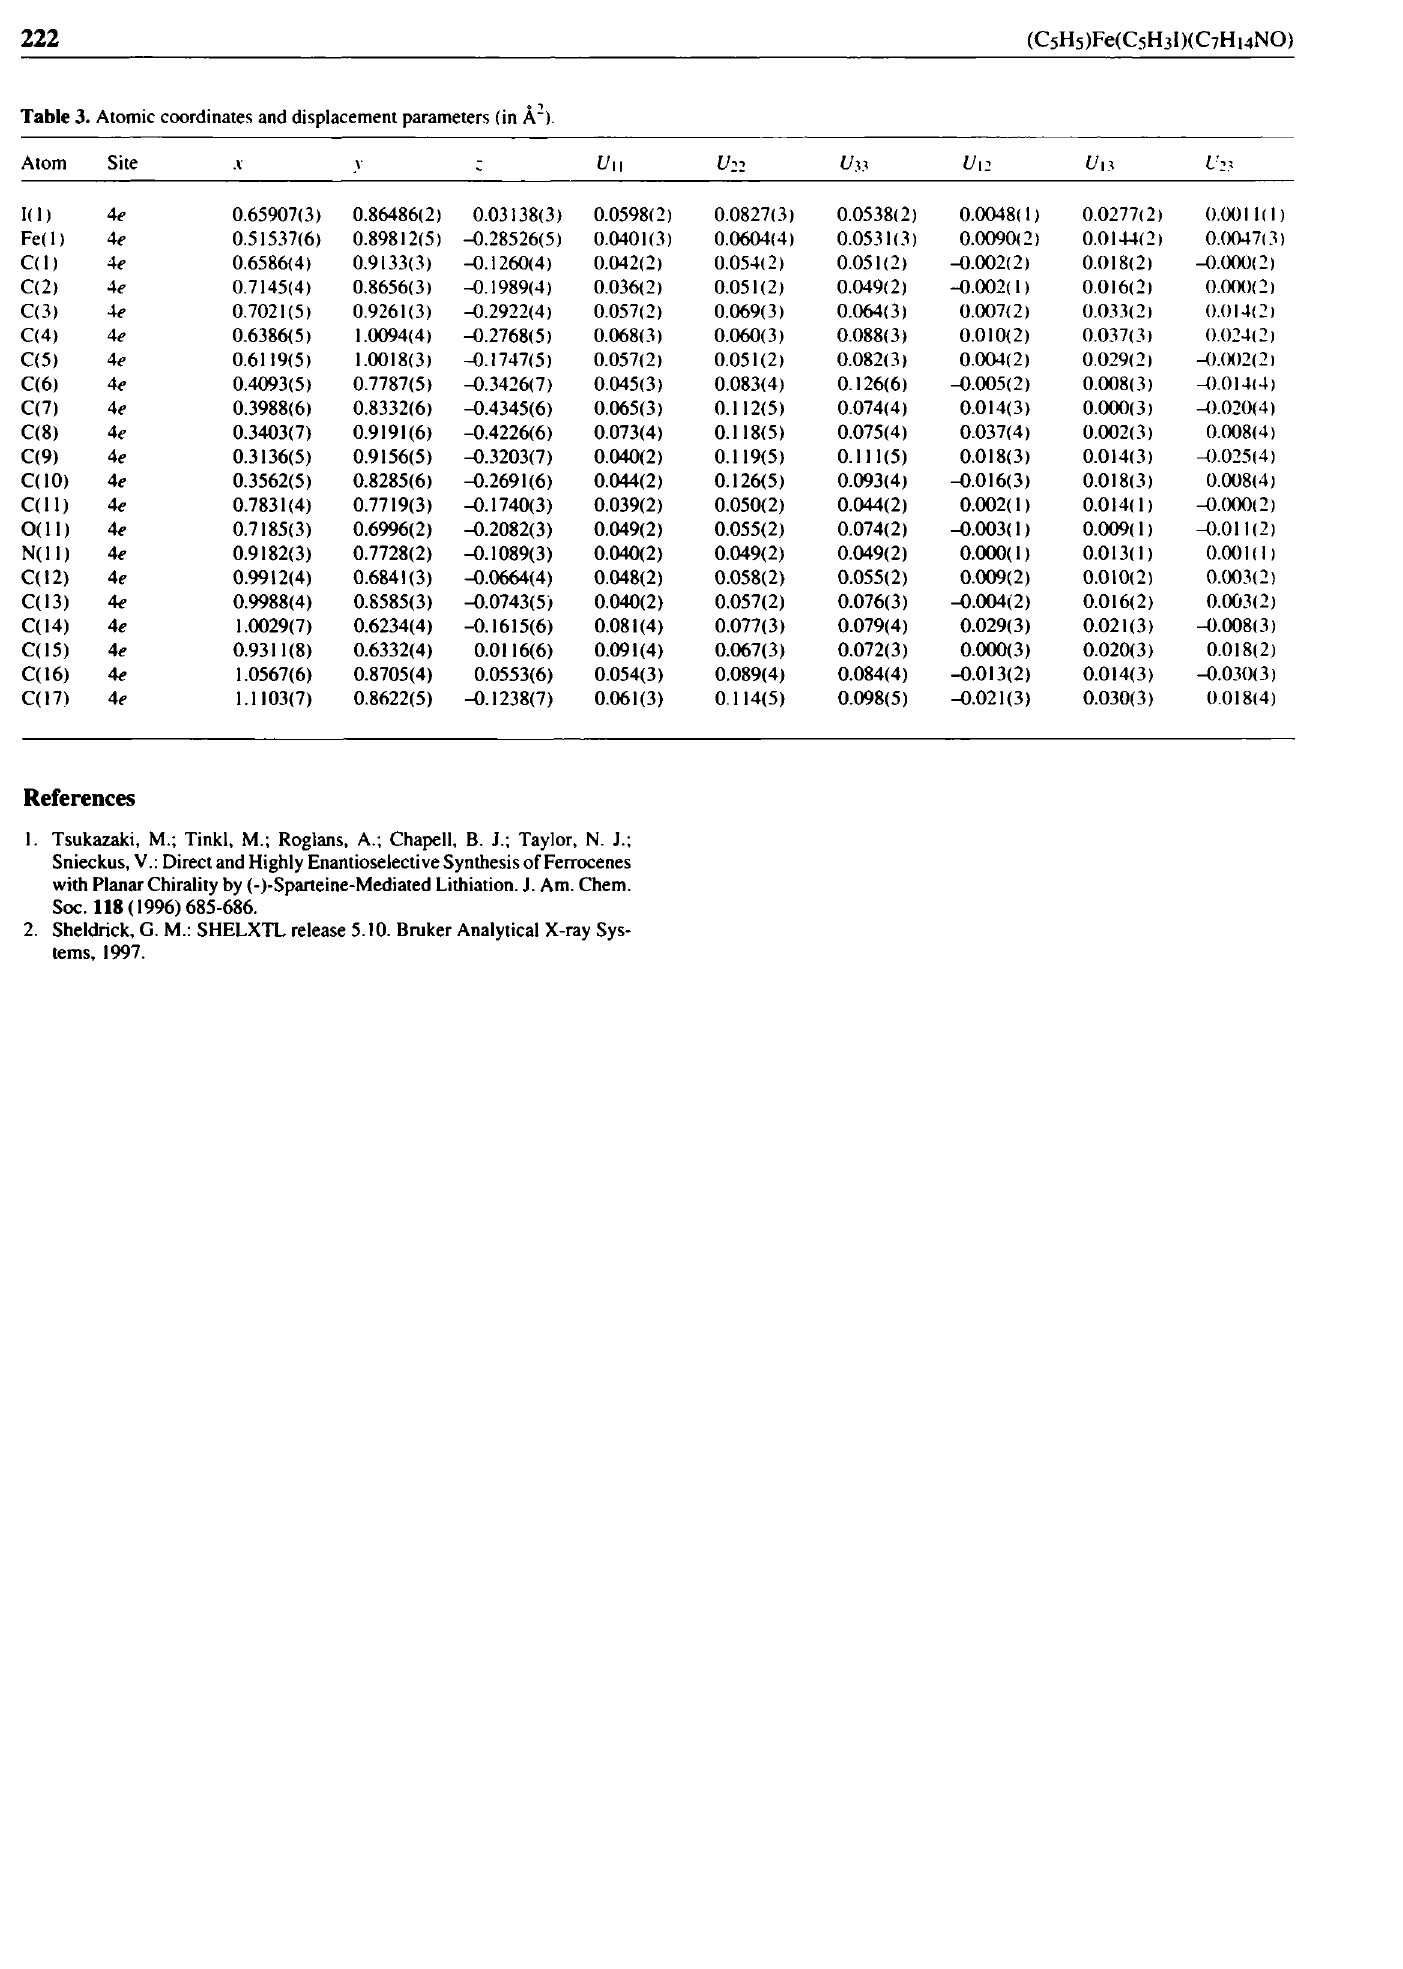
Table 3. Atomic coordinates and displacement parameters (in A 2